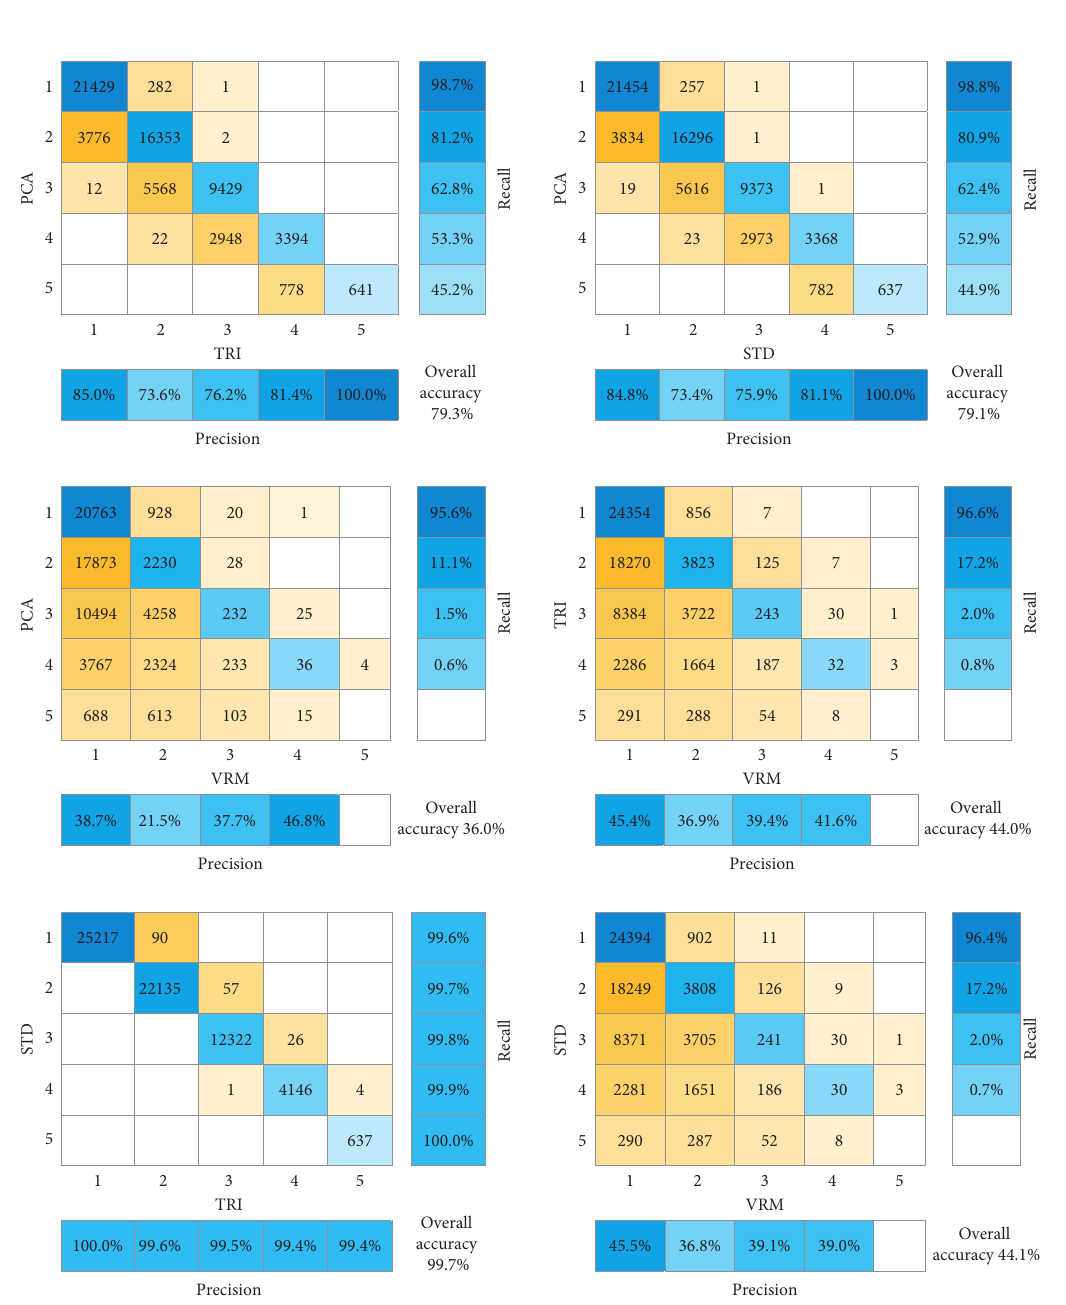
Figure 17: Confusion matrix for each pair of the investigated models.